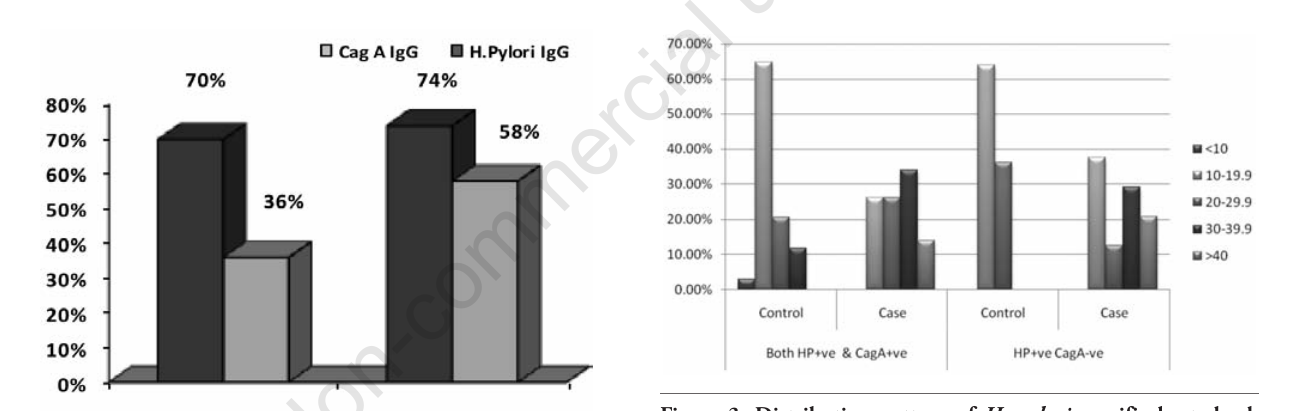
Figure 3. Distribution pattern of H. pylori specific heat shock protein-60 antibody levels in H. pylori and cytotoxin associated gene A infection.